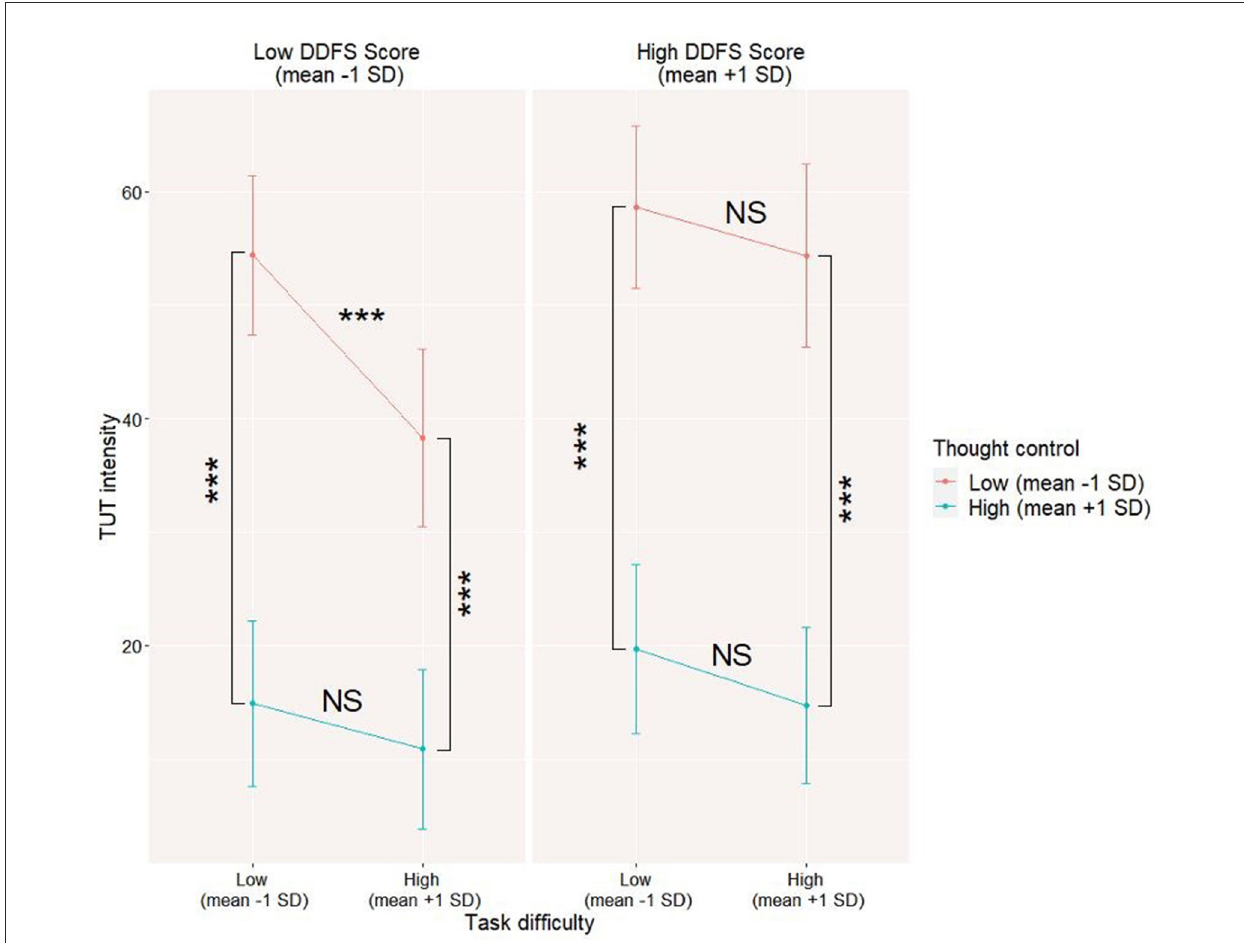
FIGURE3 Daydreaming Frequency Scale (DDFS) moderating level 1 interaction between thought control and task difficulty on task-unrelated thoughts (TUT) level. The data for the moderation model were visualized by computing slopes for high (mean + 1SD) and low (mean-1SD) levels of each predictor and moderator. NS—not significant; *** p <